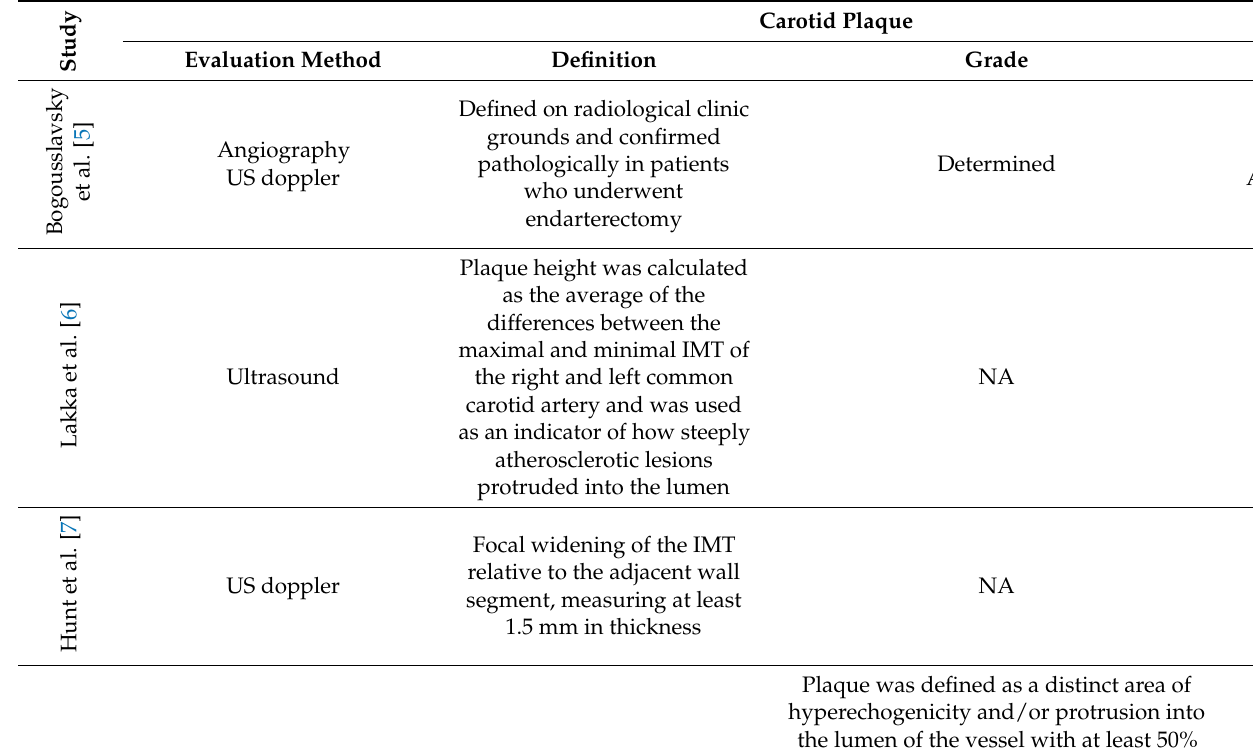
Table 3. Data collected about carotid plaque and